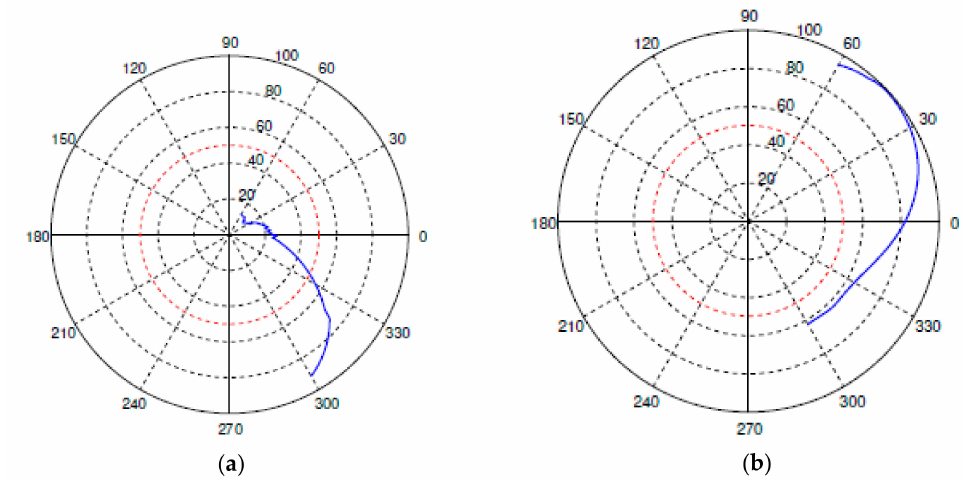
Figure 12. Result of Guth VCP simulation for sunny sky conditions: ( a ) wire skylight glazing; ( b ) di ff use skylight